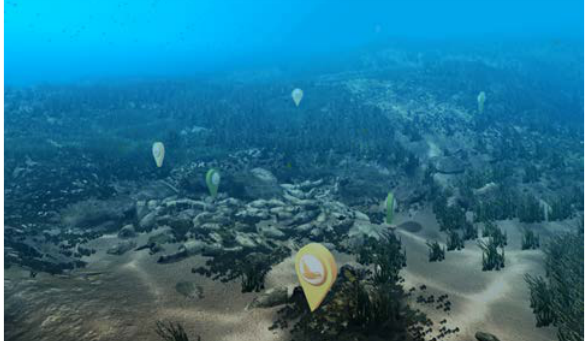
Figure 8. Virtual scene of the underwater archaeological site of Cala Minnola.